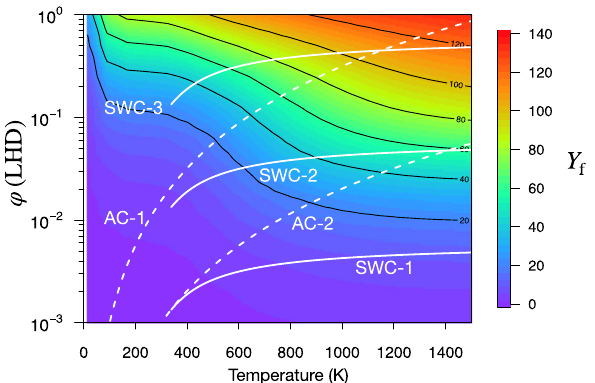
Figure 6. Fusion yields Y f as functions of ϕ and T . The white dashed lines denote ϕ - T relation of adiabatic compression (AC-1 assumes T i = 100 K and ϕ i = 10 − solid lines denote the relationship of shock wave compression (SWC-1 assumes 300 K and initial ϕ i = 10 − SWC-2 assumes 300 K and initial ϕ i = 10 −